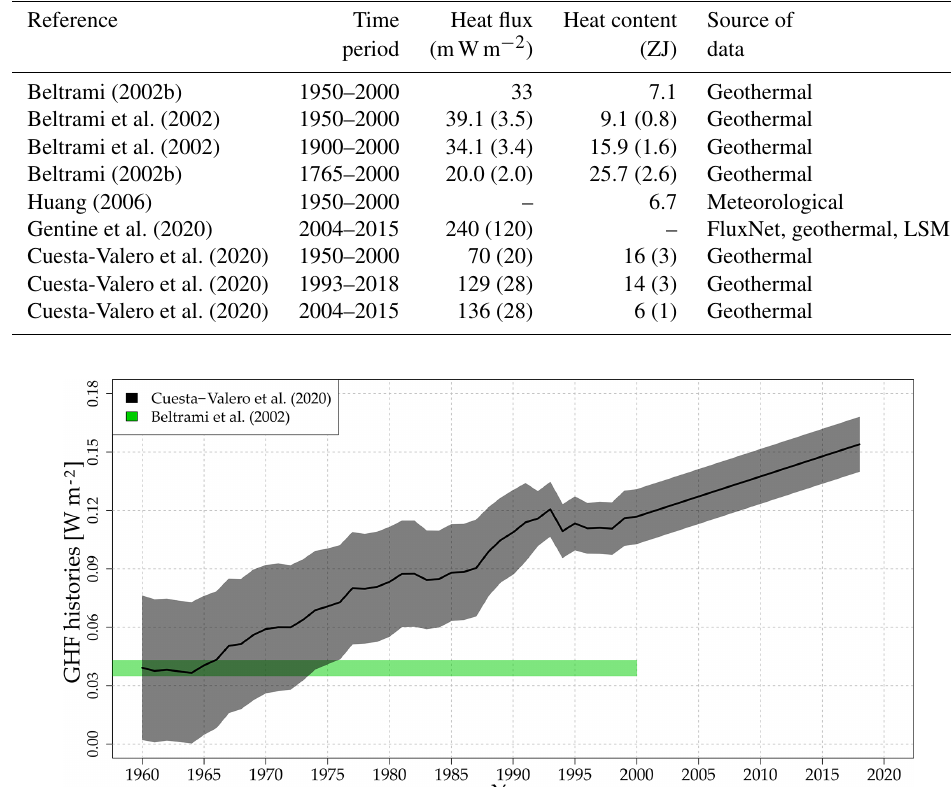
Table 2. Ground surface heat flux and global continental heat content. Uncertainties in parenthesis.